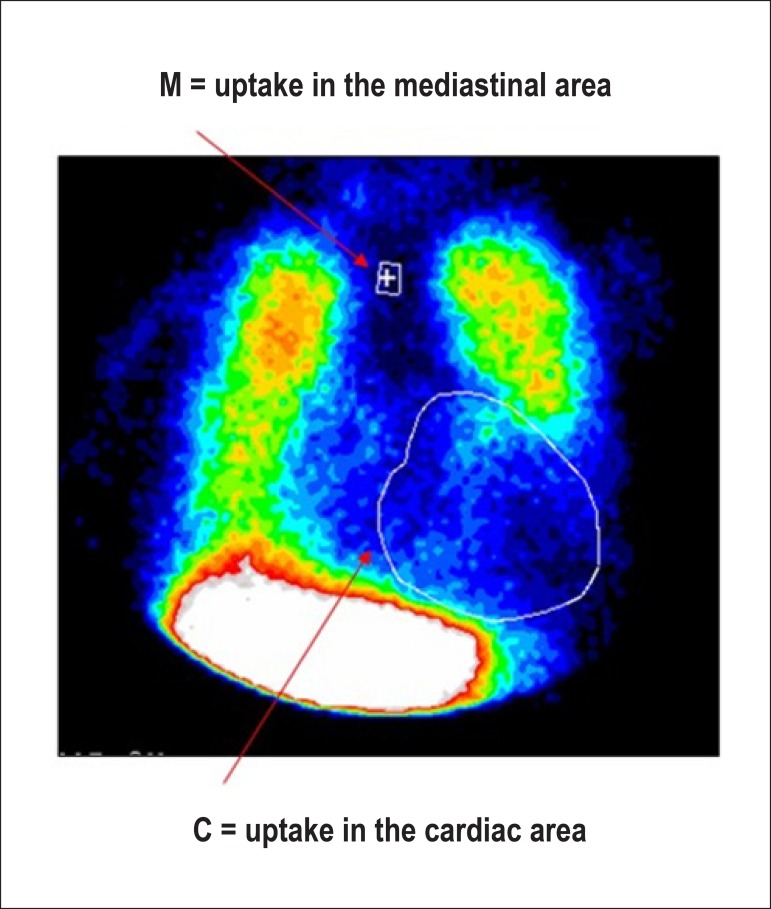
Cardiac scintigraphy with MIBG-123I. Colored late imaging of the anterior thorax with the regions of interest (ROI) drawn in the mediastinal (M) and cardiac (C) areas, to calculate the heart to mediastinum ratio (HMR) of MIBG-123I uptake. This index is the measure of the ratio between the statistical count of the rate of average radiation per pixel in the ROI, drawn in the heart and mediastinum.